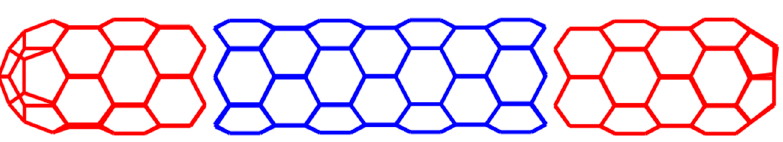
Figure 16. The 3-dimensional structure of fullerene graph A 12 n+ 4 .